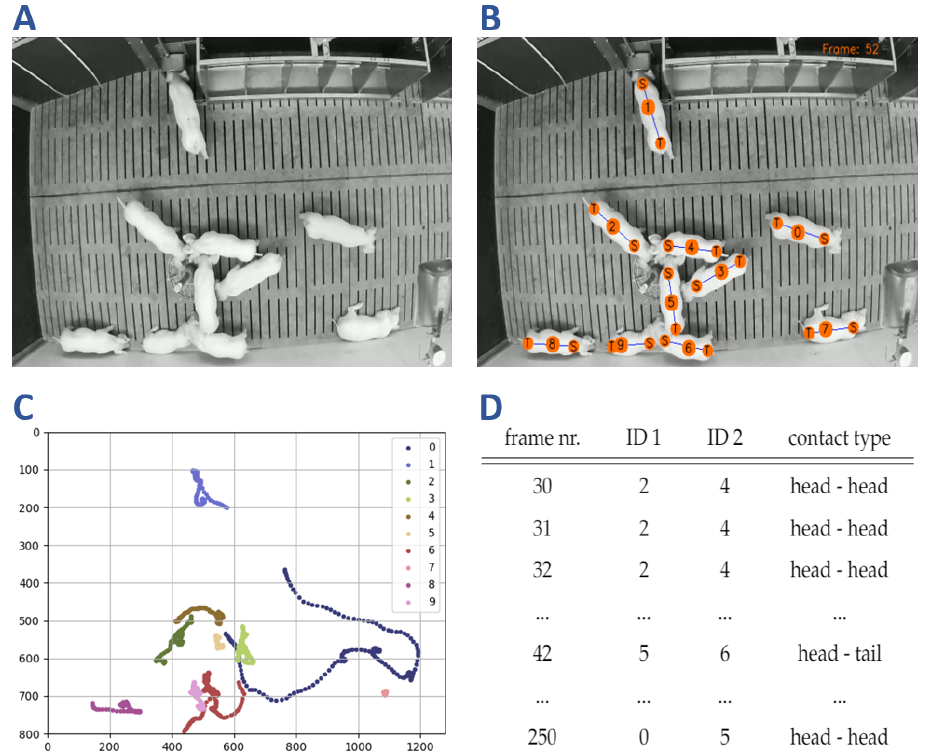
Figure 10. The social contact identification starts with a raw video frame ( A ). After detecting the shoulder and tail position ( B ), the trajectories are computed and analyzed over time ( C ). By identifying cases of close distances, a table of social contacts is constructed automatically ( D